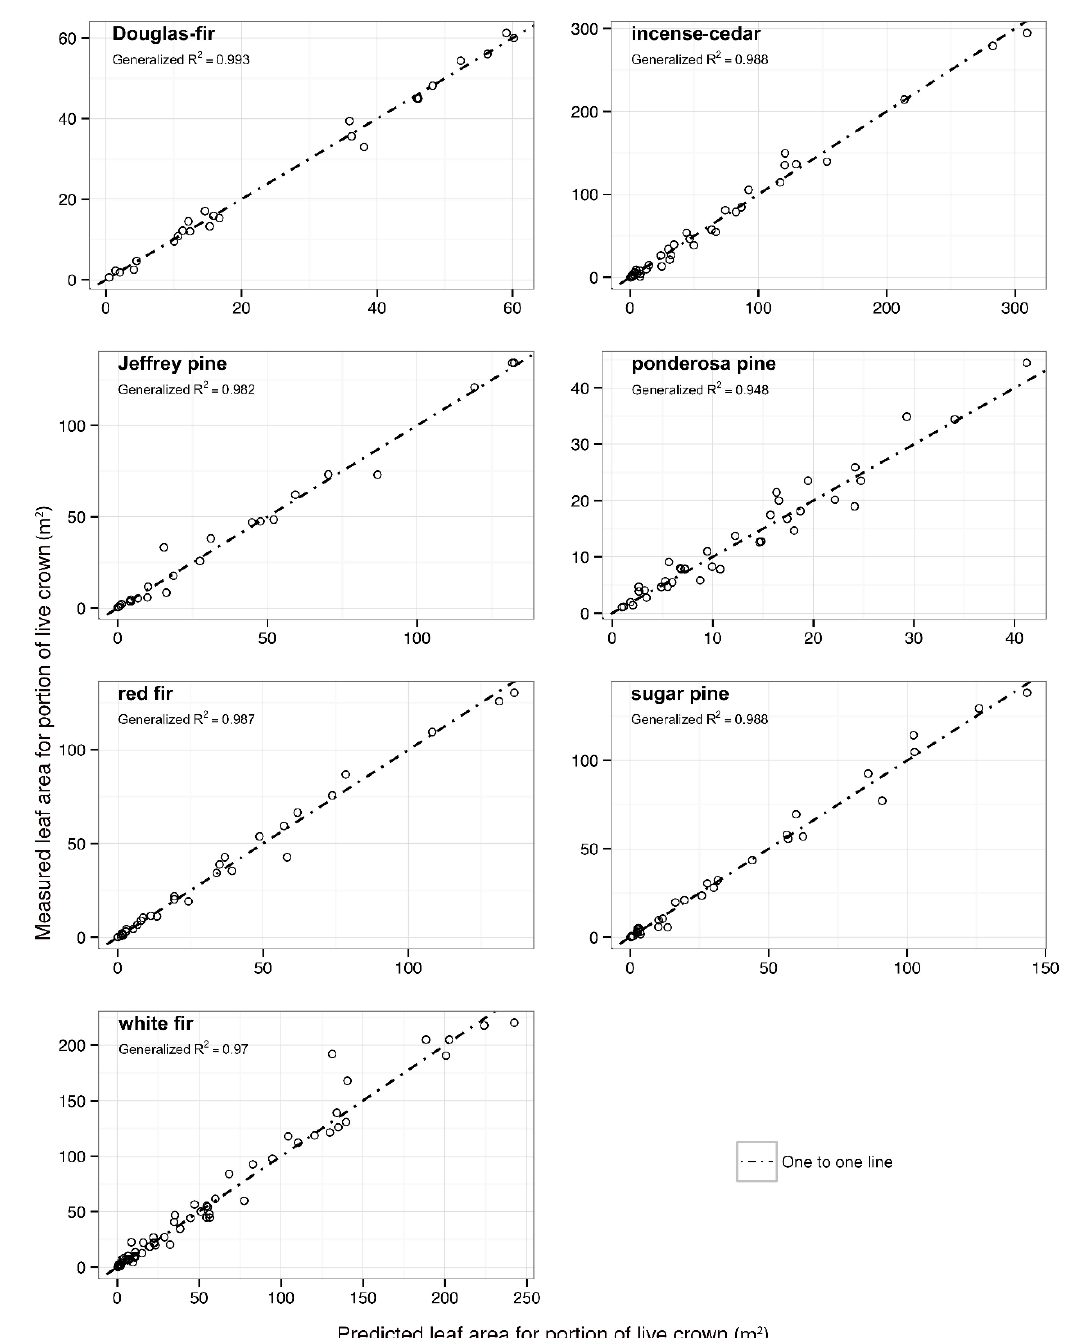
Figure 2. Measured leaf area for a crown portion as a function of predicted leaf area above a point in the crown for seven conifer species. Generalized R 2 are shown as well as one-to-one lines to indicate scatter around the theoretical line of perfect